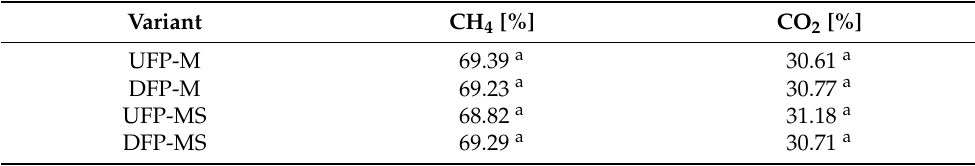
Table 5. Methane (CH 4 ) and carbon dioxide (CO 2 ) content in produced biogas.